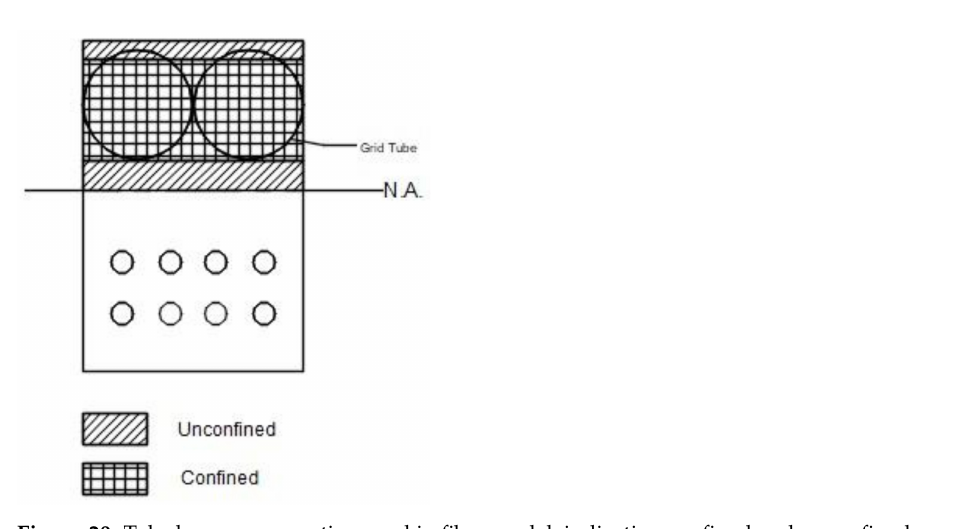
Figure 20. Tube beam cross-section used in fiber model, indicating confined and unconfined concrete